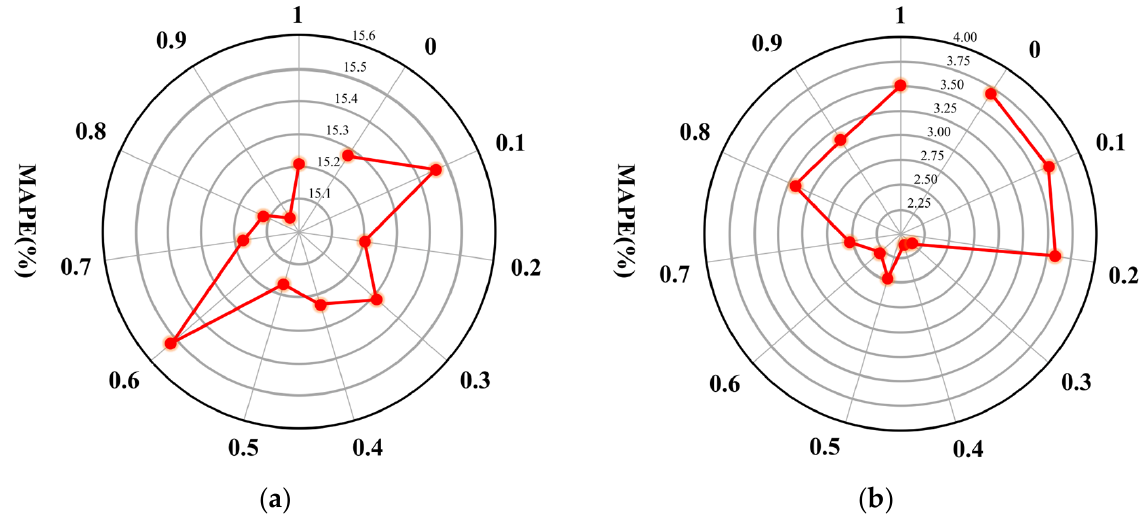
Figure 9. MAPE variation with the different proportions of topology and human mobility information on the: ( a ) Shenzhen dataset; ( b ) Xi’an dataset.